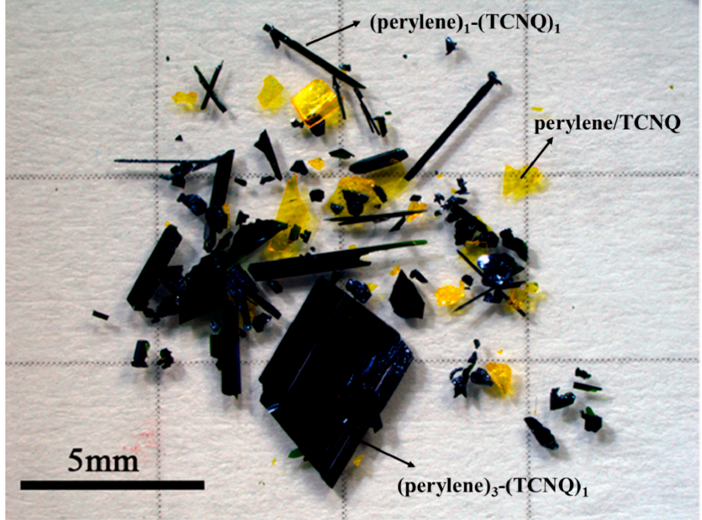
Figure 6. A typical mixture of phases grown in an open gas-phase single-crystal growth system with flowing argon gas. Data are reproduced with permission from [37].